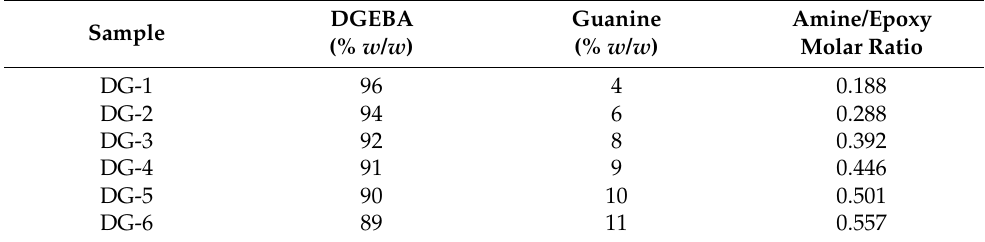
Table 2. Compositions of the investigated DGEBA/guanine